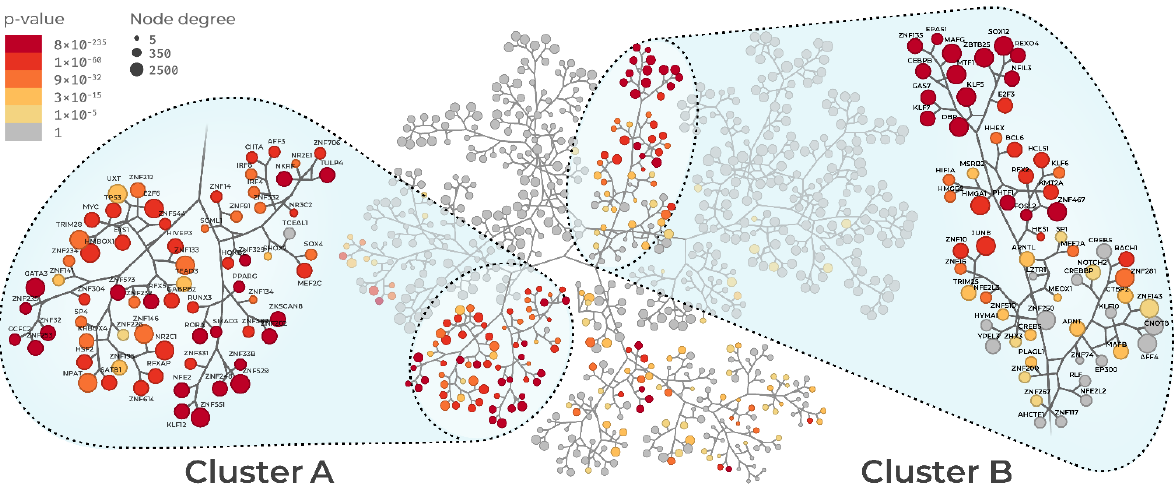
Figure 3. Tree-and-leaf representation of the Pediatric Sepsis 2 (GSE4607) regulatory network. Nodes represent regulatory units labeled after their transcription factors. Node size represents regulon connectivity with regulated genes (degree); node color represents adjusted p -value (FDR < 0.01) of MR enrichment for sepsis condition. Dotted lines denote the two main connected clusters of regulons, cluster A and B.